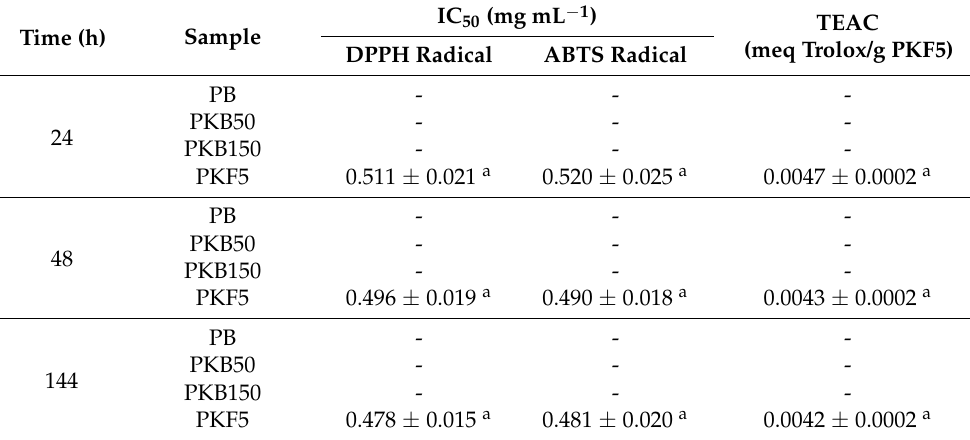
Table 5. Antioxidant activities of gluten-free bread as a function of time. Each measurement was carried out in triplicate, and data are expressed as means ( ± SD).